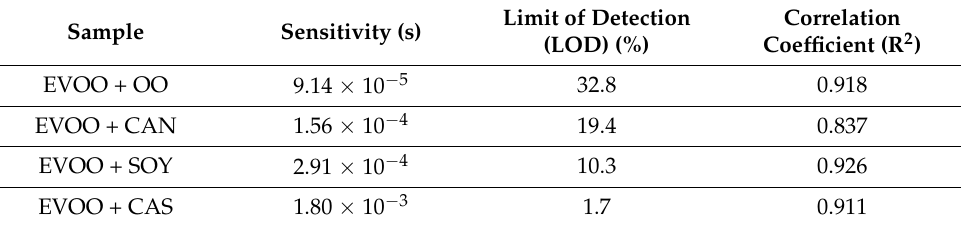
Table 2. Summary of sensor performance parameters for EVOO adulteration detection. Extra